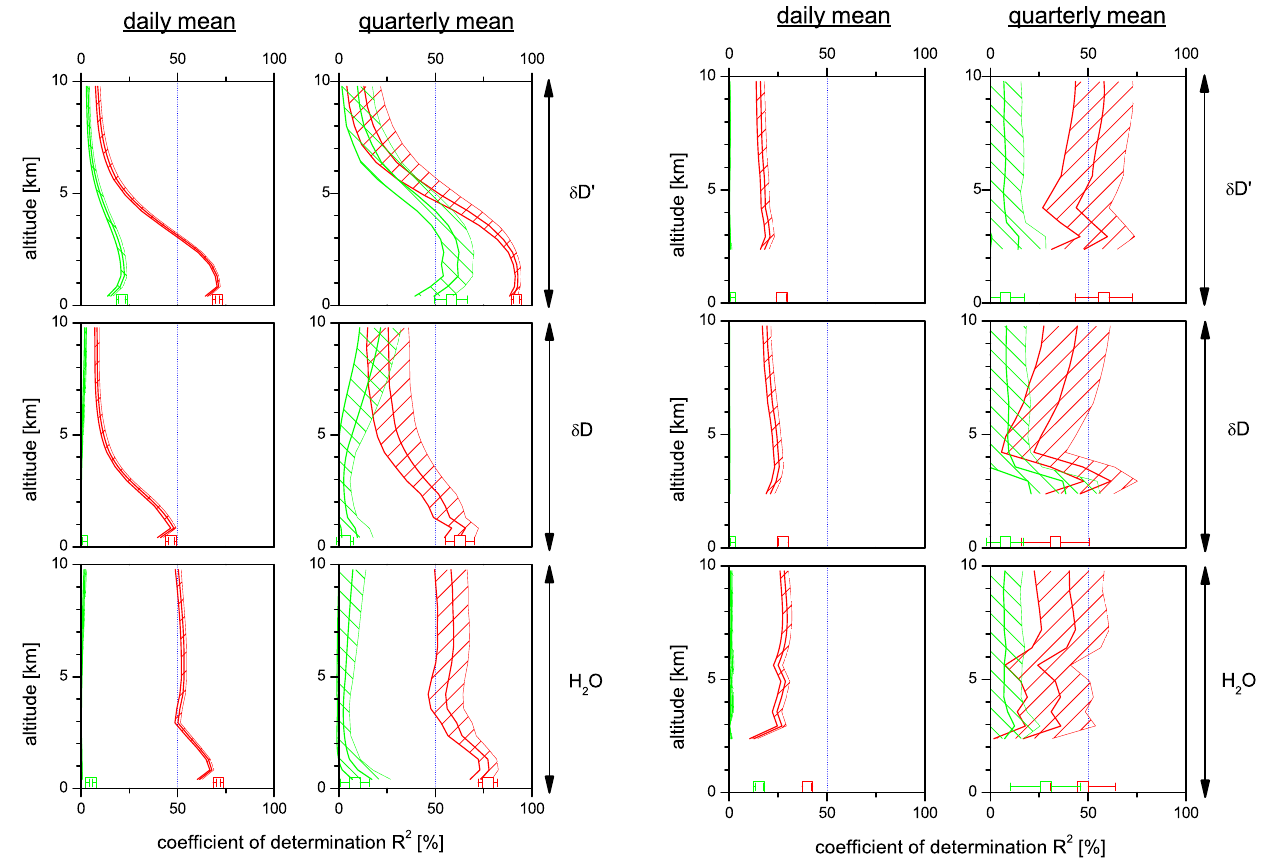
Fig. 12. Same as Fig. 11 but for Fig. 11. Profiles of the coefficients of determination R 2 between deseasonalised FTIR and IsoGSM data of Kiruna. From the bottom to the top: H 2 O (H 2 O variability expressed as ln [ H 2 O ] ), δ D, and δ D 0 ( δ D and δ D 0 variability expressed as ln [ HDO ] [ ). Left: daily H 2 O ] mean data, right: quarterly mean data. Red curve for nudged and green curve for free run IsoGSM (hatched area represents the 1 σ significance intervals). The open squares and error bars upon the bottom x-axis represent R 2 and 1 σ significance interval for column integrated data.